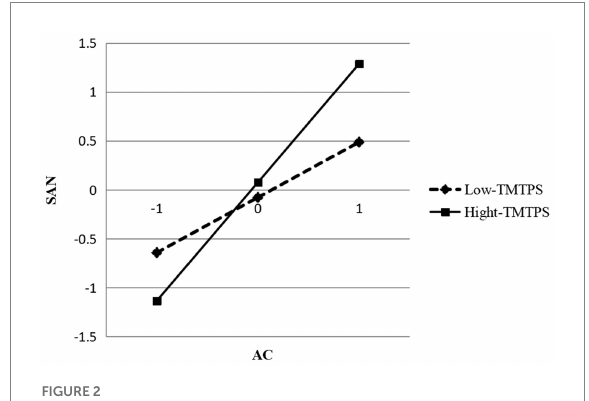
FIGURE 2 Moderating effect of TMTPS between AC and SAN.